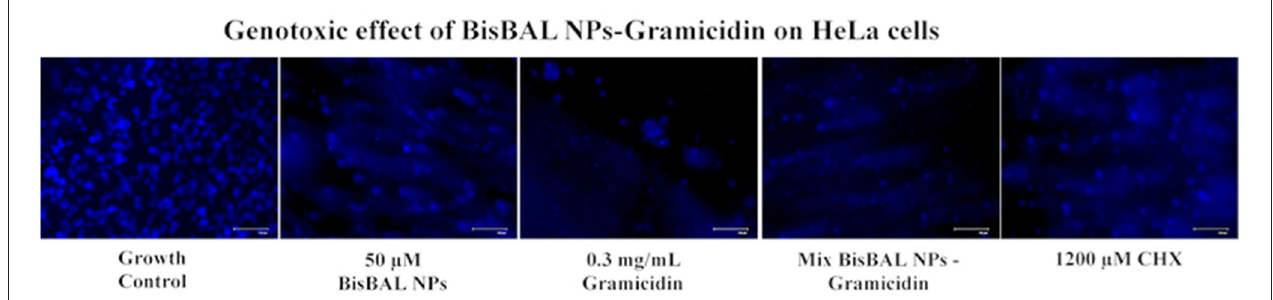
FIGURE 8 | Genotoxic effect of gramicidin alone or in combination with BisBAL NPs on HeLa cells. Tumor cells were exposed for 24h to 0.3 mg/mL gramicidin, 50 µ M of BisBAL NPs, or a BisBAL NPs/gramicidin mixture. 1,200 µ M chlorhexidine served as a positive control of genotoxic effect. DNA damage was analyzed by the comet assay and fluorescence microscopy. Bar indicates 125 µ